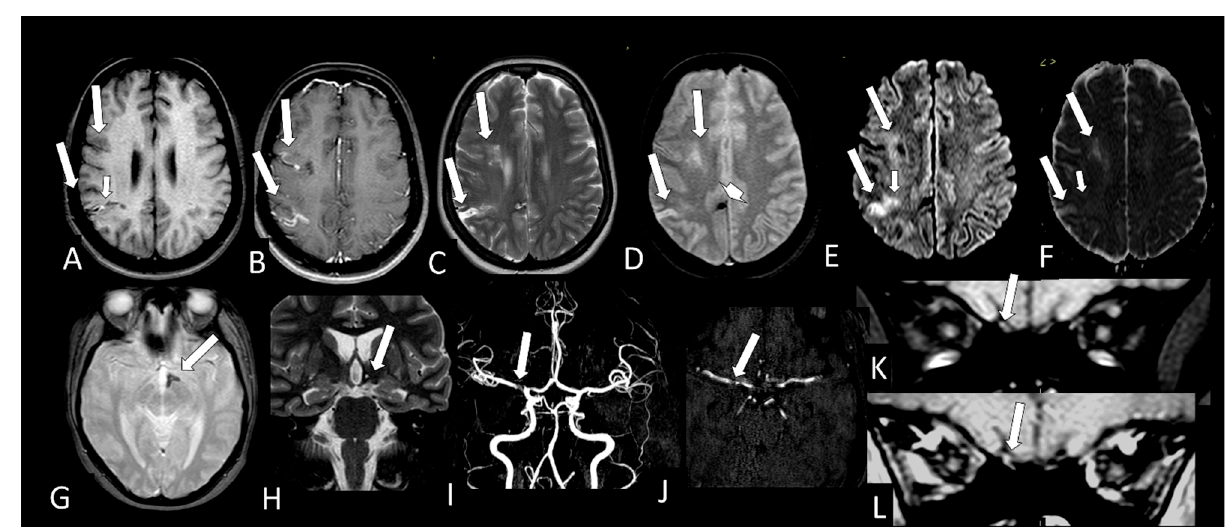
Figure 6. Case 18—On MRI, there is a small round lesion on the splenium of the corpus callosum which could represent a cytotoxic lesion due to a cytokine storm and differential diagnosis is with small acute infarct. It is hypointense on T1 ( A , arrow) with restricted diffusion, being hyperintense on DWI ( B , arrow) and hypointense on ADC ‐ Map ( C , arrow). This lesion is also hyperintense on FLAIR ( D , arrow) and T2* ( E , arrow) without microbleeding. The olfactory bulbs are hyper ‐ intense on coronal post contrast fat suppressedT1WI ( F , arrows) in comparison to the gray matter of the frontal lobes, which can represent enhancement, but we cannot exclude microbleeding.